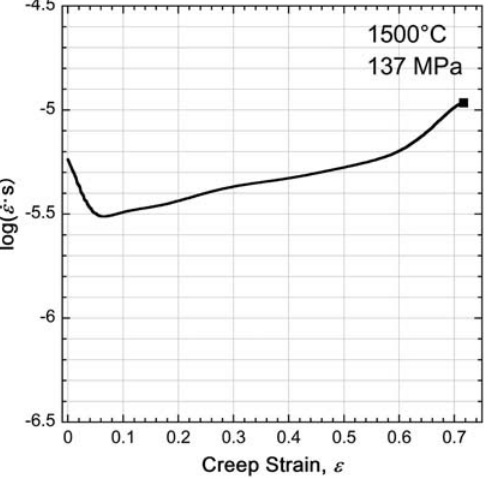
Figure 1: Logarithmic strain rate vs. creep strain of the MoSiBTiC alloy crept at 1,500°C and 137